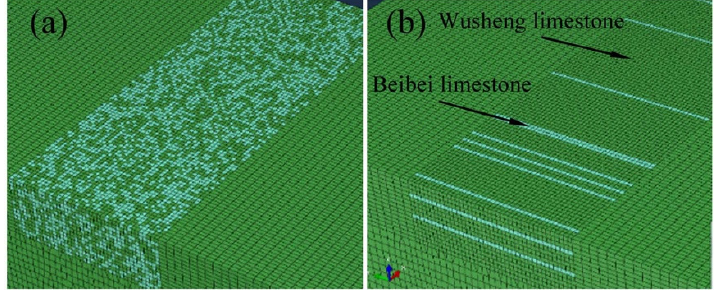
Figure 18. Heterogeneous formations: ( a ) The sandstone formation with a high content of gravels; ( b ) The soft-hard staggered formation.